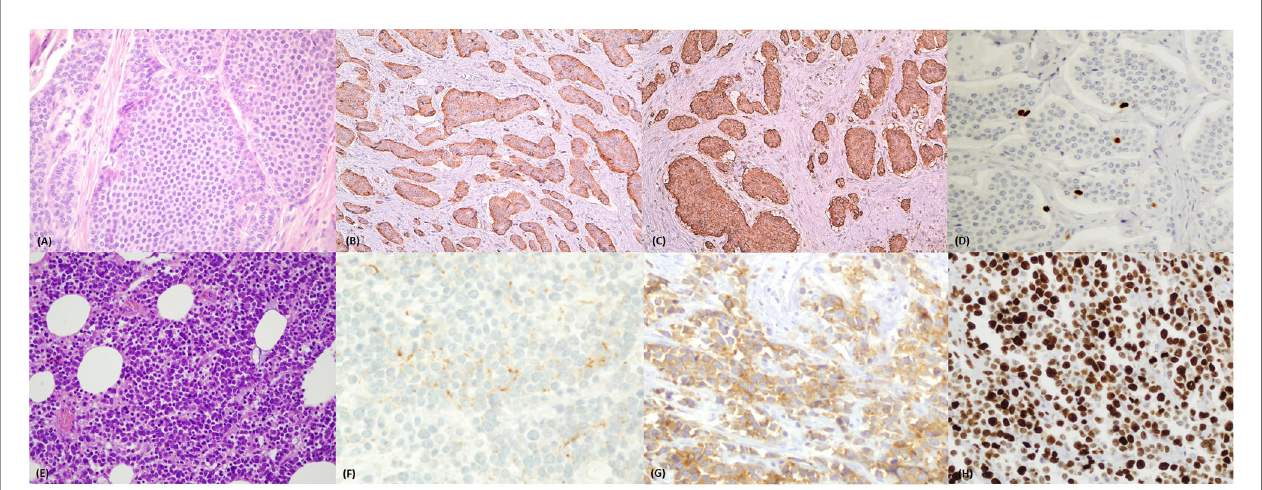
FIGURE 1 | (A – D) Well differentiated neuroendocrine tumor of the ileum. (A) Haematoxylin and eosin stained section (magni fi cation 40x) of a well differentiated ileal neuroendocrine tumor with organoid insular architecture and monomorphic cells with ample eosinophilic cytoplasm and uniform nuclei. (B) Chromogranin A positivity and (C) synaptophysin positivity by immunohistochemistry. (D) Ki67 immunostaining showing rare positive nuclei (stained brown) with <3% proliferation ratio – grade 1. (E – H) Poorly differentiated neuroendocrine carcinoma of the colon. (E) Haematoxylin and eosin stained section (magni fi cation 40x) of a poorly differentiated neuroendocrine carcinoma showing solid structure and small/moderate atypical cells with scanty cytoplasm and hyperchromatic nuclei. (F) Focal dot like positivity for Chromogranin A but diffuse, cytoplasmic expression of synaptophysin (G) . (H) Ki67 immunostaining showing diffusely positive nuclei (stained brown) with 90% proliferation ratio – grade